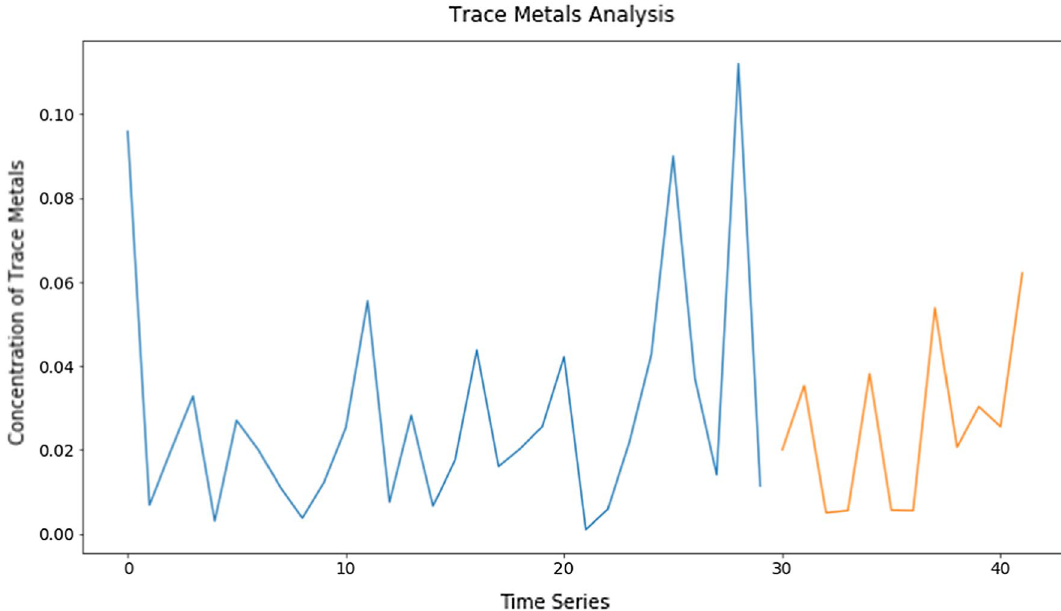
Fig. 5 Trace metal prediction using machine learning (machine learning with